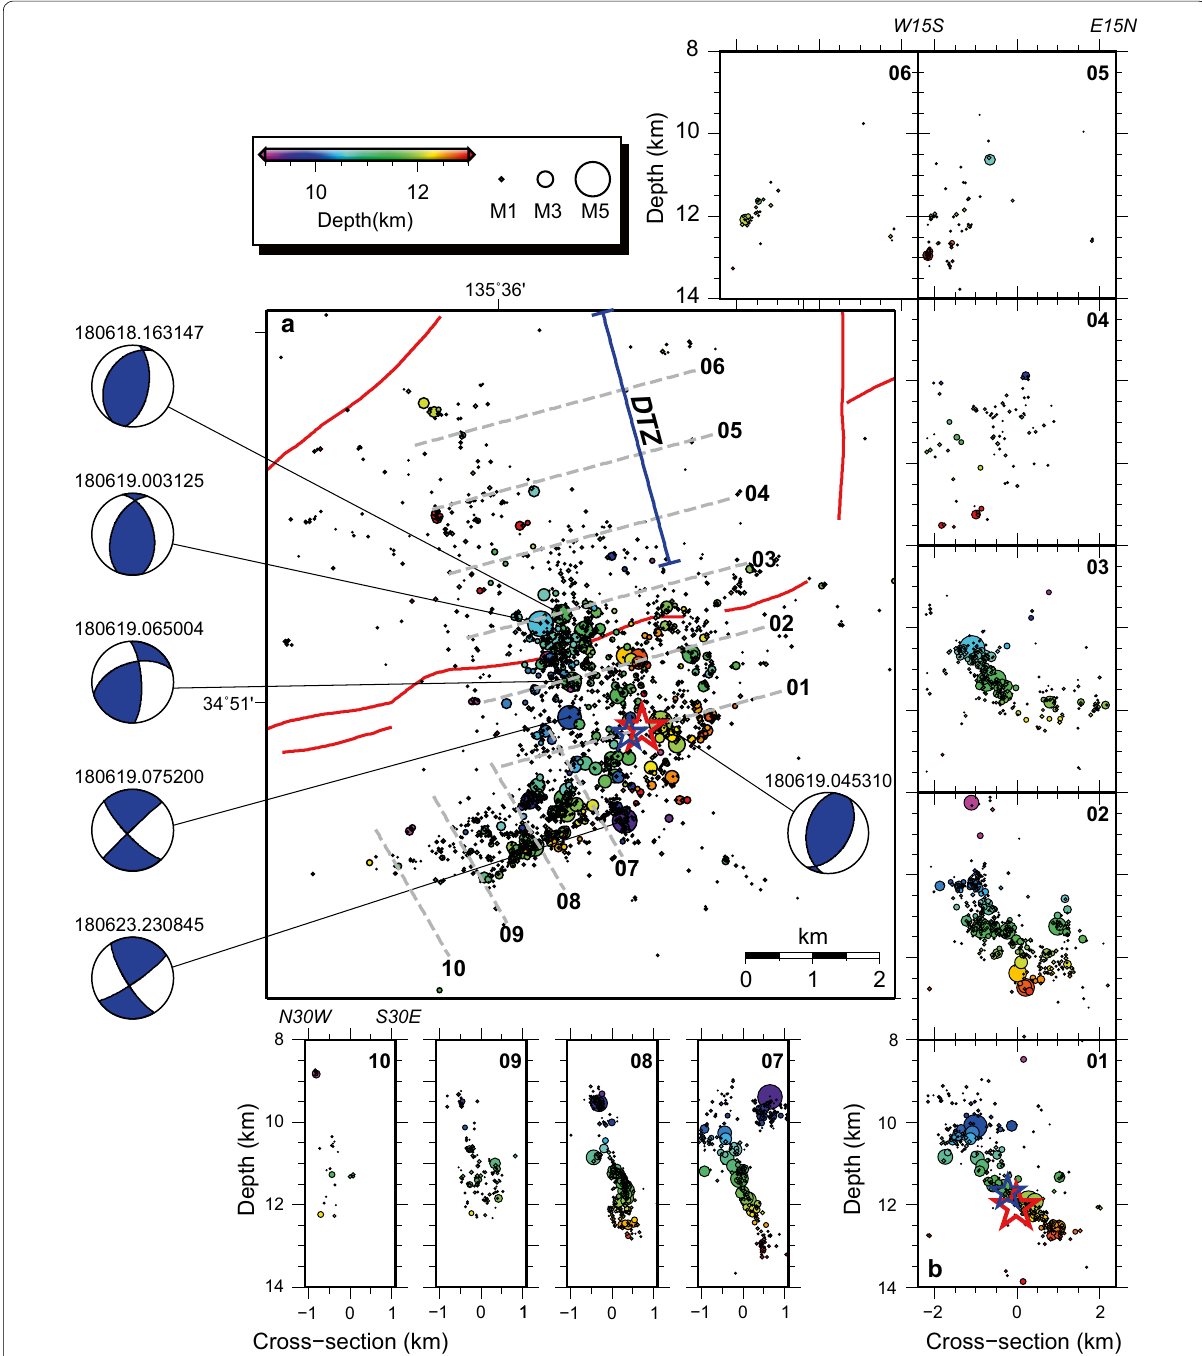
Fig. 2 Relocated earthquakes associated with the 2018 M w 5.6 northern Osaka earthquake. a Map view of the relocated epicenters, which are shown as circles that are scaled to earthquake magnitude and colored to hypocentral depth. The blue beach balls denote the aftershock focal mechanisms estimated by NIED (origin time is above each beach ball, in YYMMDD.HHMMSS format). The blue and red stars are the epicenters of the foreshock and mainshock event, respectively. The red lines denote the surface traces of active faults in the area. DTZ indicates the zone with delayed triggered aftershocks (see text). b Depth sections of the relocated hypocenters along the profiles shown in Fig.